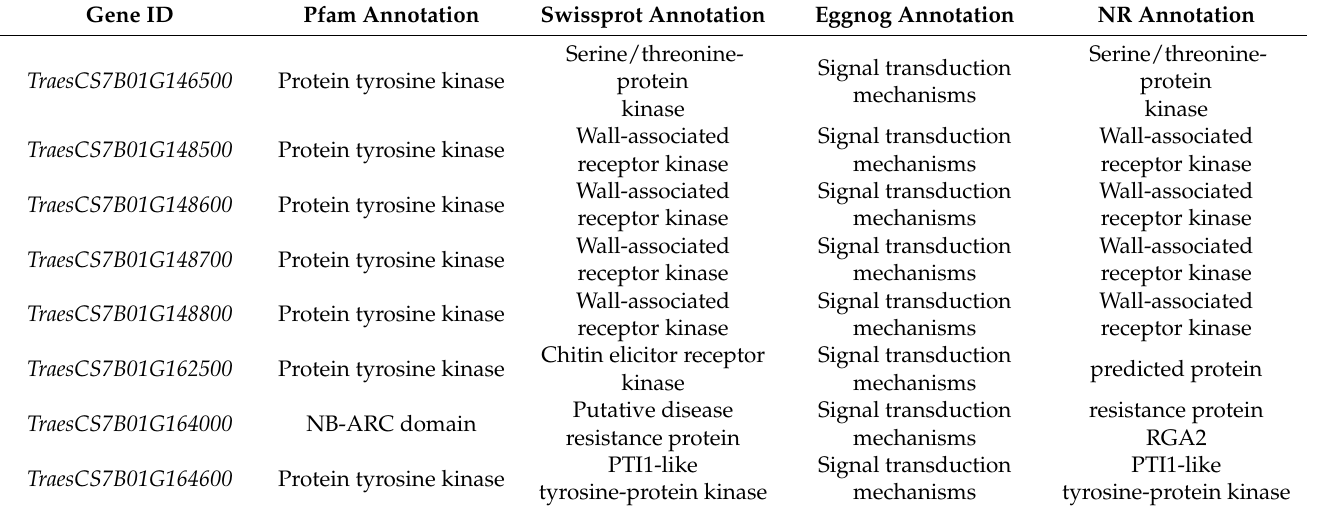
Table 1. NBS-LRR and RLK genes within the Pm40 region were annotated in Pfam, SwissPort, Eggnog, and NR Database. Gene ID Pfam